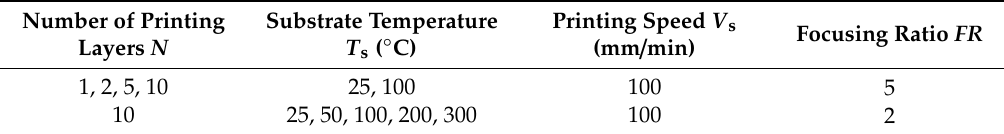
Table 1. Parameters of the aerosol jet printing process to establish the e ff ect of the number of printing layers N and the temperature of the heated substrate T s on the characteristics of the lines